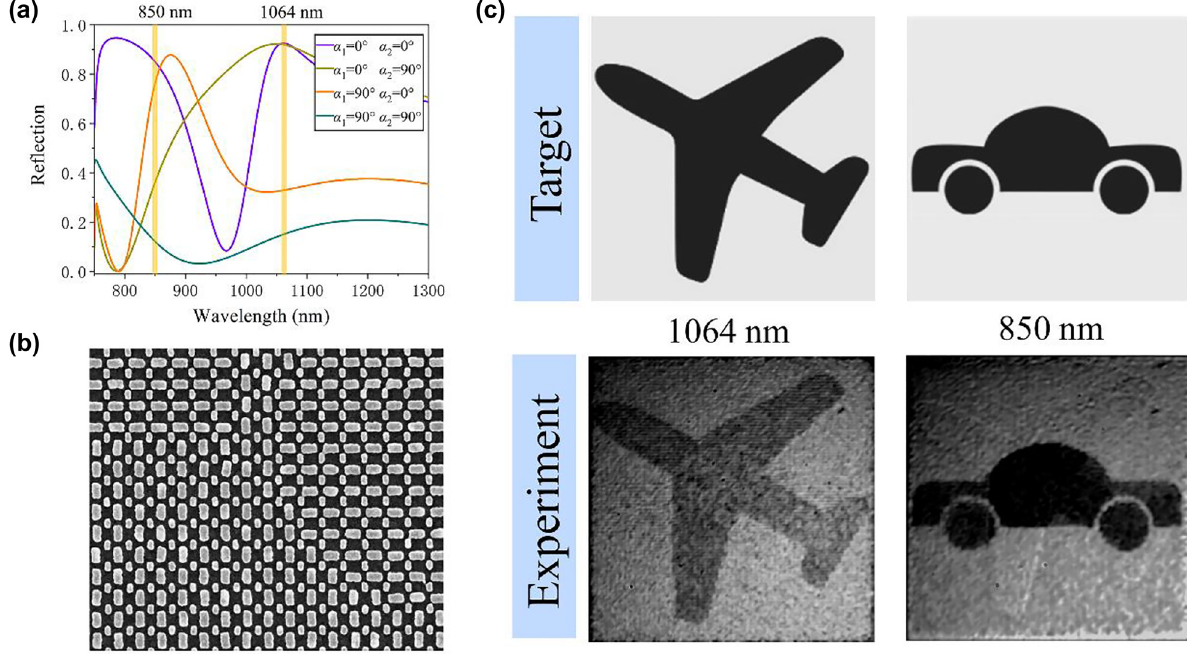
Figure 4: Wavelength encoded display metasurface. (a) The simulated reflection spectra of the supercells with different orientation angles. (b) SEM image of wavelength encoded metasurface composed of R1 and R2. (c) Target images and experimental results of wavelength encoded metasurface at 1064 nm and 850 nm incidences, respectively.